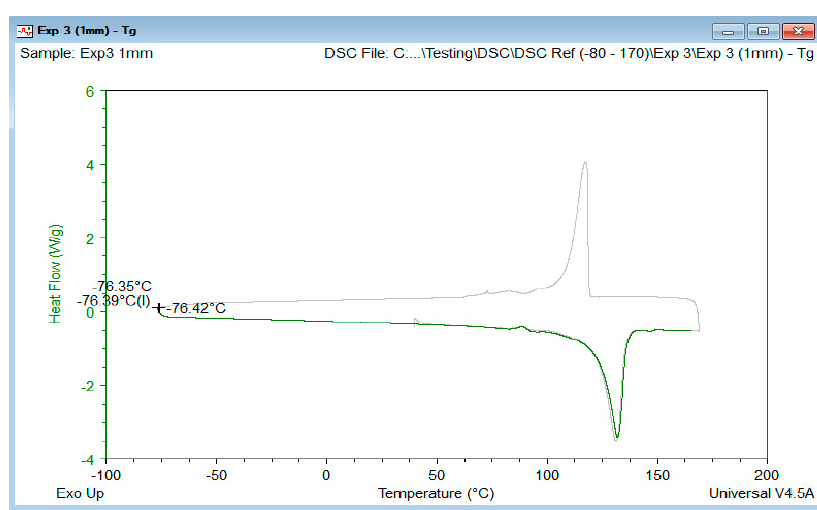
Materials 2021 , 14 , x FOR PEER REVIEW 17 of 19 Figure A3. T g of HDPE after Experiment 2. Figure A3. T g of HDPE after Experiment 2.